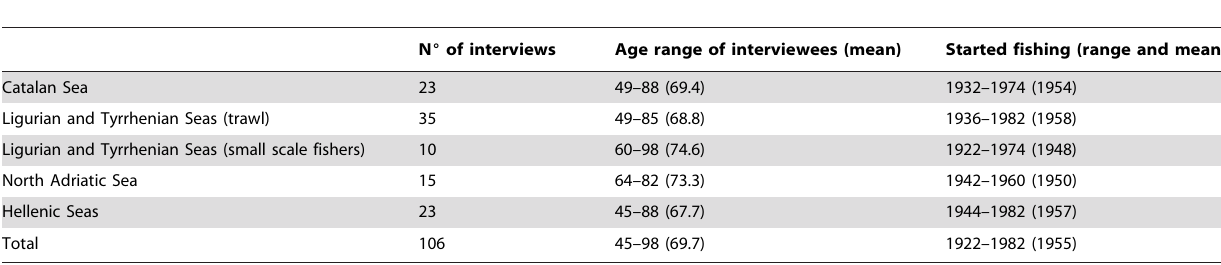
Table 1. Survey interview data showing the number of fishers interviewed in each area, their age and their experience in the